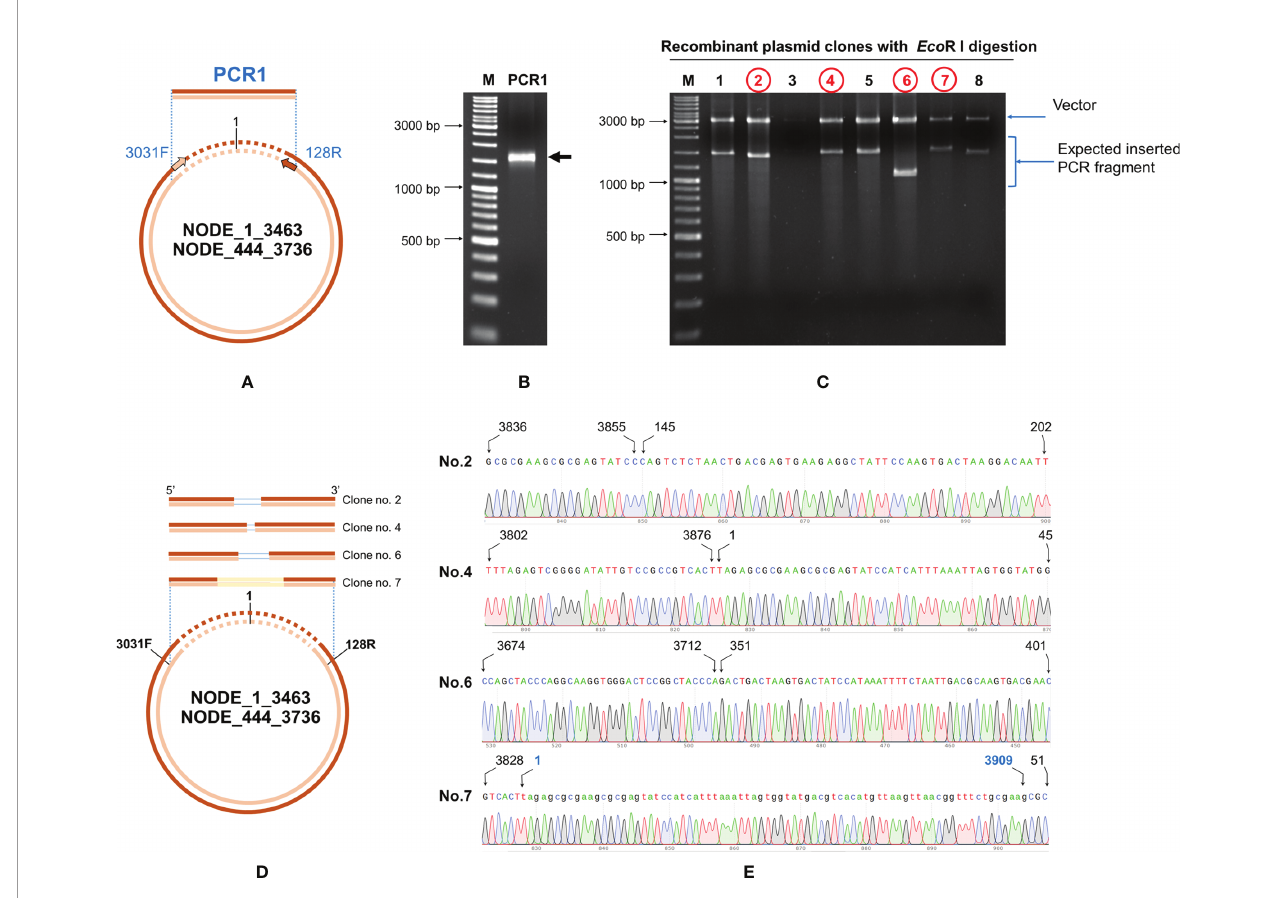
FIGURE 7 | Con fi rmation of IHHNV-cvcDNA sequences homologous to GenBank record AF218266 by PCR and DNA sequencing. (A) A diagram using ID NODE_1-3463 as a model with primer positions (IHHNV3032F/IHHNV128R) and ampli fi cation directions indicated. (B) Photograph of an electrophoresis gel showing the ampli fi ed broad band of approximately 1,500 bp that was obtained from use of primers IHHNV3031F/IHHNV128R. (C) Eco RI digestion of the plasmid preparations from 8 selected clones. The plasmid of clone no. 2, 4, 6, and 7 (in red) were subjected to sequencing using T7/SP6 primers. (D) Diagram showing PCR sequence reads and alignments of the cvcDNA variants corresponding to the reference contigs no. NODE_1_3463 or NODE 444-3736. The ring represents a model cvcDNA of variable overall length with the orange portion indicating the contigs for NODE_1_3463 or NODE 444-3736. The orange boxes above the circle indicate variations in contiguous, ampli fi ed closure lengths that also share 99% identity to AF218266. The lines within some of the boxes simply indicate which missing part of the match to AF218266 has resulted in the smaller closure length. (E) Junction analysis based on PCR fragment sequencing in (C) showing a chromatogram for continuous DNA reads. None of the closed circles contained a match to a whole IHHNV genome sequence. Numbers indicate nucleotide position corresponding to reference genome accession no.